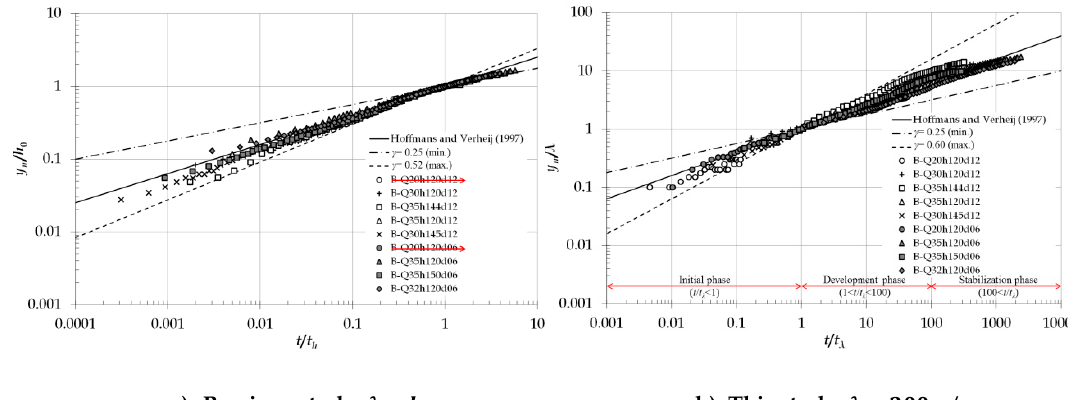
Figure 8. Normalized maximum scour depth as function of time. Table 3. Measured quantities of scour test.